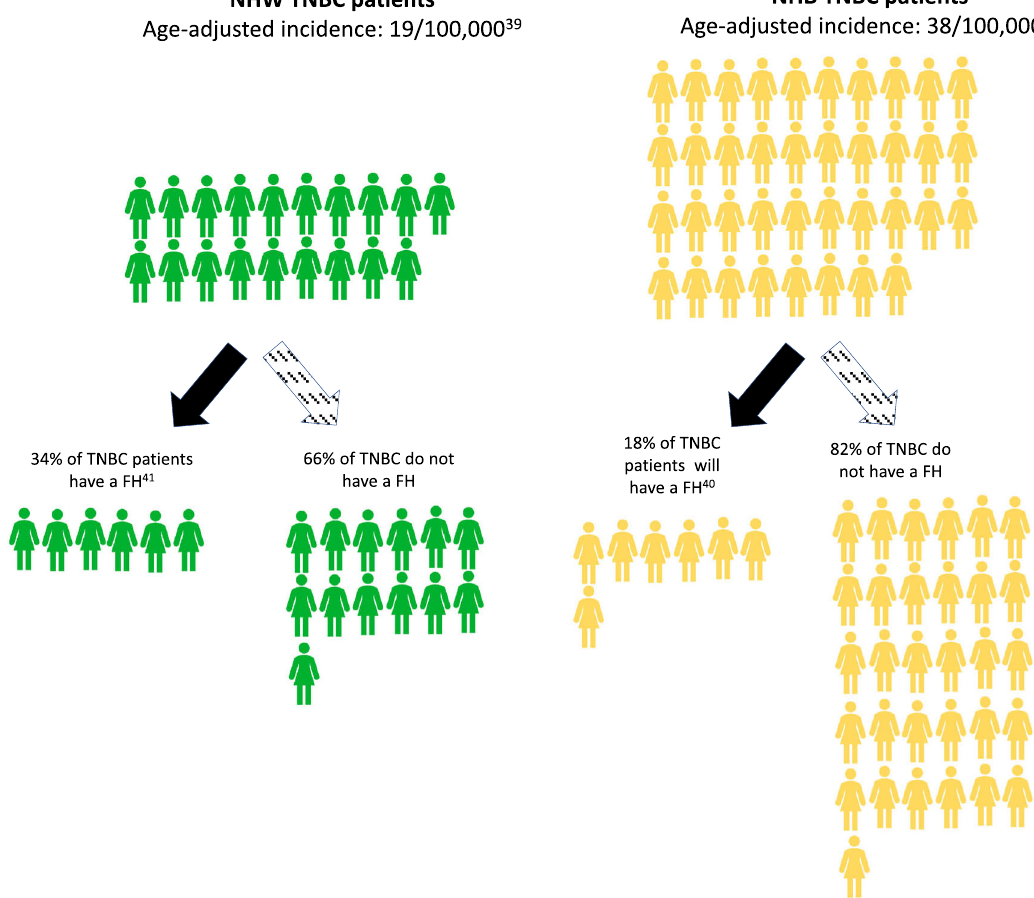
Fig. 2 Family history guidelines lead to many missed women at risk for breast cancer. Potential rate difference between NHB and NHW women based on the estimated percent with family history of cancer for TNBC. The age-adjusted incidence for TNBC is 19 per 100,000 and 38 per 100,000 for NHW and NHB women, respectively. 34% and 18% of NHW and NHB TNBC patients, respectively, report a family-history of BC. Assuming a conservative 100% uptake in genetic counseling and testing, this translates into an estimated incidence rate difference between NHB and NHW women with TNBC without a family history of 31 versus 13 per 100,000. Abbreviations: NHW non-Hispanic white, NHB non-Hispanic black, TNBC triple negative breast cancer, FH family